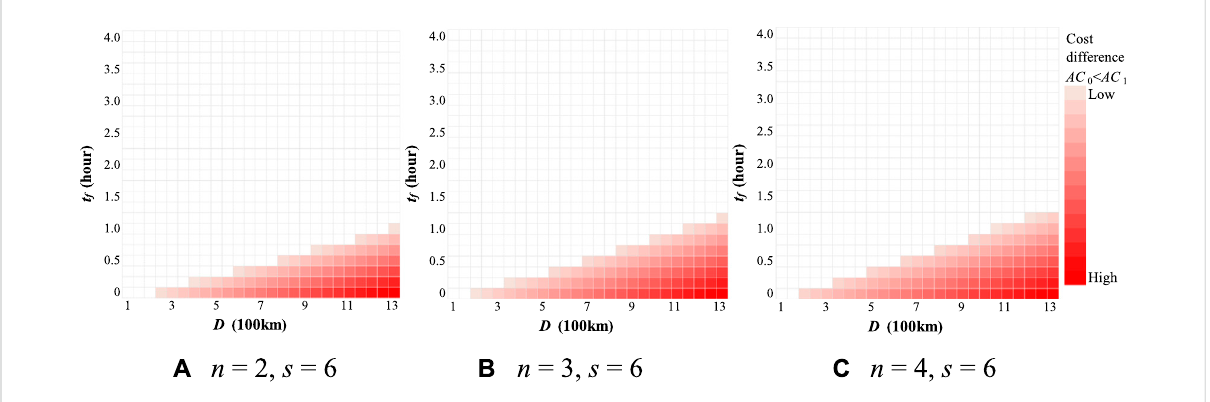
FIGURE 6 CostcomparisonbetweenCase0(singletruck)and1(truckplatooning) foradifferentnumberofplatoonedtrucks( n ). (A) n =2, s =5 (B) n =3, s = 6 (C) n = 4, s = 6.